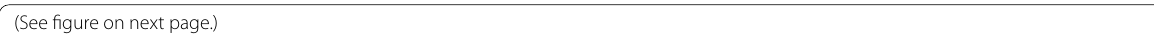
figure on next Fig. 1 The GINS4 was frequently upregulated in glioma. A Based on GEPIA2 database, the expression levels of GINS4 in various tumors were shown. On top labels, the color of the tumor name represents the level of GINS4 in the tumor compared with the corresponding normal tissues. Red indicates the high level of GINS4 in tumor tissue: Bladder Urothelial Carcinoma (BLCA), Breast invasive carcinoma (BRCA), Cervical squamous cell carcinoma and endocervical adenocarcinoma (CESC), Colon adenocarcinoma (COAD), Lymphoid Neoplasm Diffuse Large B-cell Lymphoma (DLBC), Esophageal carcinoma (ESCA), Glioblastoma multiforme (GBM), Head and Neck squamous cell carcinoma (HNSC), Lung squamous cell carcinoma (LUSC), Ovarian serous cystadenocarcinoma (OV), Pancreatic adenocarcinoma (PAAD), Rectum adenocarcinoma (READ), Skin Cutaneous Melanoma (SKCM), Stomach adenocarcinoma (STAD), Testicular Germ Cell Tumors (TGCT), Thymoma (THYM), Uterine Corpus Endometrial Carcinoma (UCEC), and Uterine Carcinosarcoma (UCS); Green indicates the low level of GINS4 in tumor tissue: Acute Myeloid Leukemia (LAML); Black indicates that there is no significant difference between the level of tumor tissue and normal tissue: Adrenocortical carcinoma (ACC), Cholangio carcinoma (CHOL), Kidney Chromophobe (KICH), Kidney renal clear cell carcinoma (KIRC), Kidney renal papillary cell carcinoma (KIRP), Brain Lower Grade Glioma (LGG), Liver hepatocellular carcinoma (LIHC), Lung adenocarcinoma (LUAD), Mesothelioma (MESO), Pheochromocytoma and Paraganglioma (PCPG), Prostate adenocarcinoma (PRAD), Sarcoma (SARC), Thyroid carcinoma (THCA), Uveal Melanoma (UVM); B The expression level of GINS4 was compared between glioma cell lines and corresponding normal cell lines by RT-qPCR. C The expression level of GINS4 was compared between 17 glioma tissues and 10 corresponding normal brain tissues by